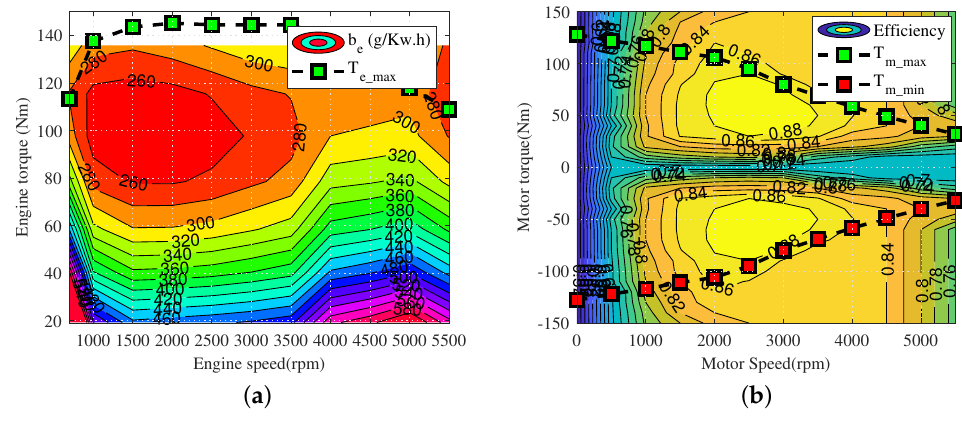
Figure 2. The b e map of the engine for ( a ) and efficiency map of the motor for ( b